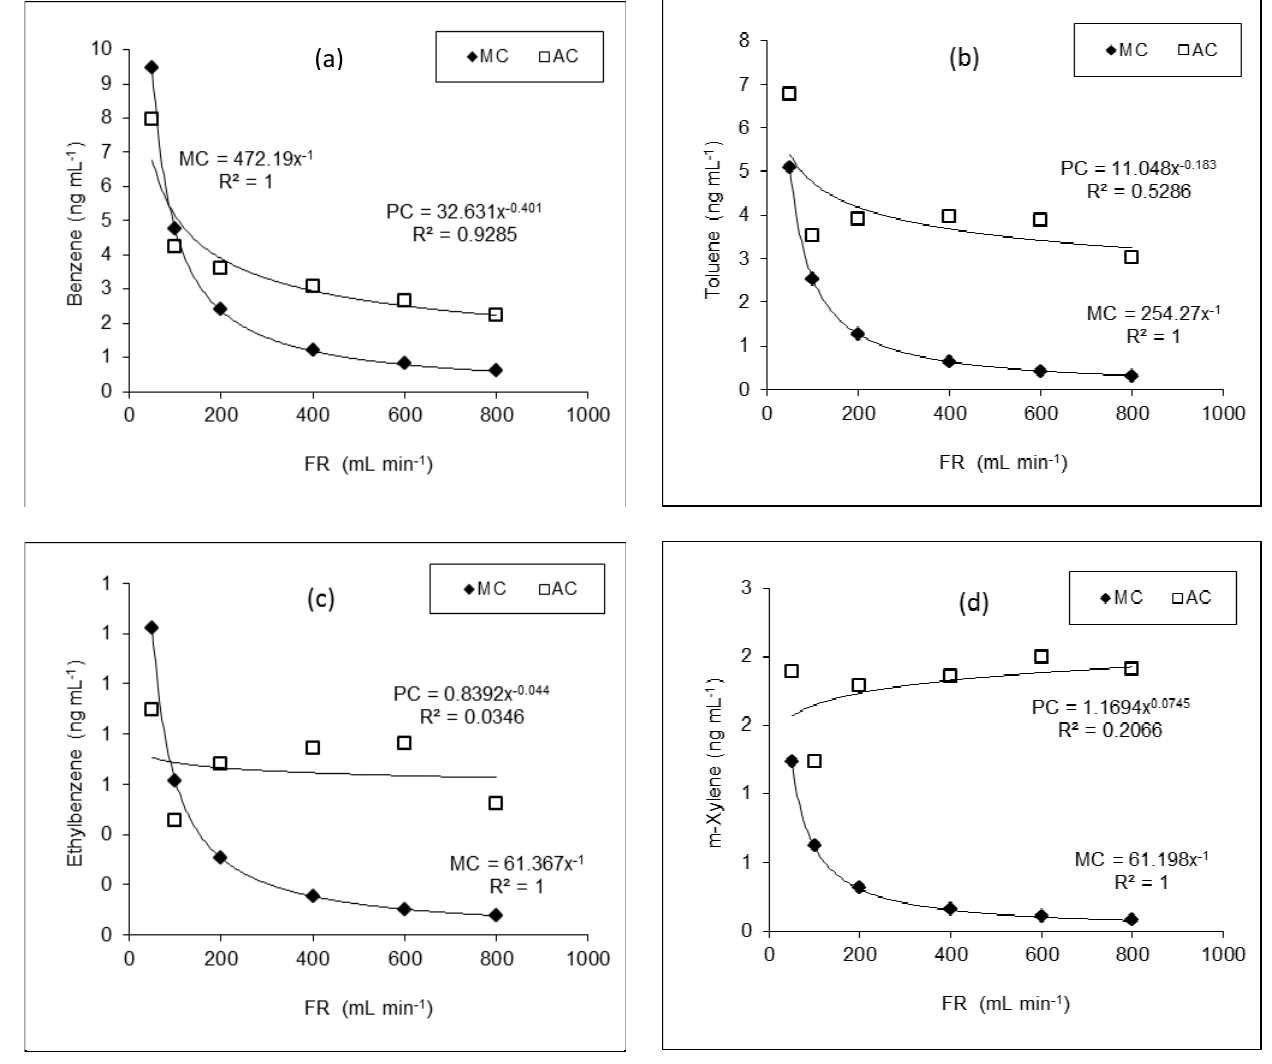
Figure 2. Comparison of BTEX data (ng·mL − 1 ) between the AC and MC as a function of diluent flow rate (mL·min − 1 ). Labels: MC = manufacturer given concentration; AC = actual measured concentration; and PC = predicted concentration using our developed